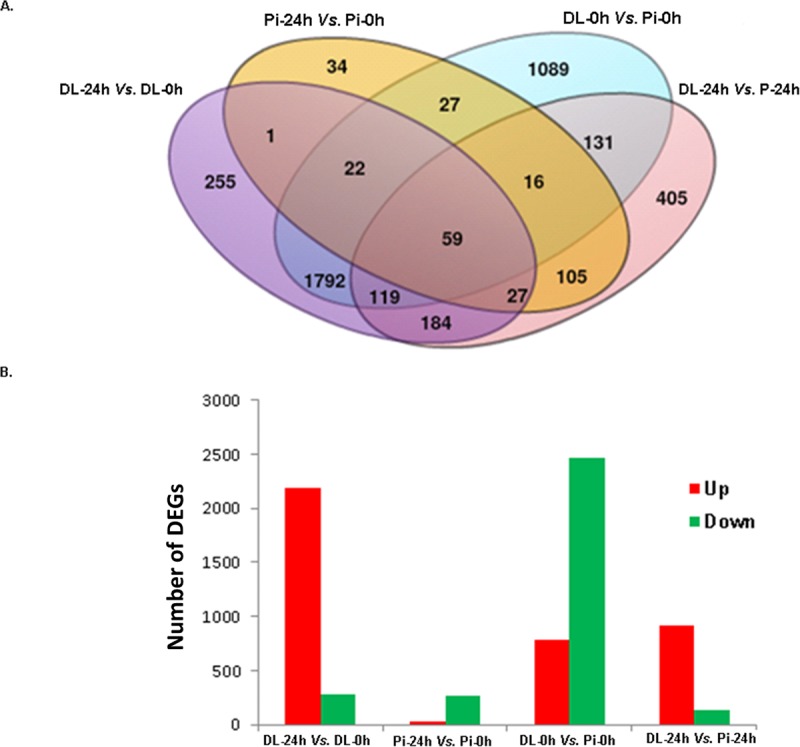
Number of DEGs after PRRSV vaccination.(A) The intersecting venn diagram demonstrates the number of DEGs identified at four contrast pairs such as PBMCs of DL pigs between pre and 24 h post vaccination (DL-24h vs. DL-0h); PBMCs of PI pigs between pre and 24 h post vaccination (Pi-24h vs. Pi-0h); unvaccinated PBMCs between DL and Pi pigs (DL-0h vs. Pi-0h), and vaccinated PBMCs between DL and Pi pigs (DL-24h vs. Pi-24h). (B) The bar graphs depict the proportion of DEGs showed their expression either up regulated (red bars) or down regulated (green bars) direction at four contrast pairs tested.